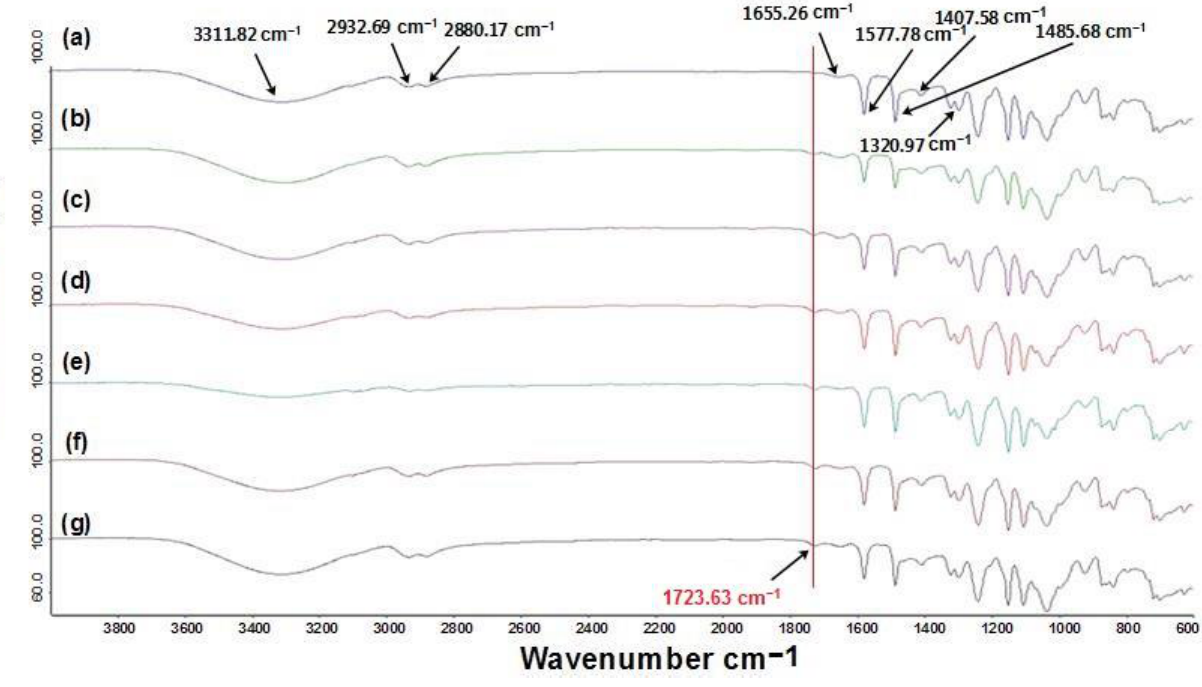
Figure 5. FTIR study of spectra of ( a ) PES, ( b ) PES/PTGM (1 wt.%), ( c ) PES/PTGM (3 wt.%), ( d ) PES/PTGM (5 wt.%), ( e ) PES/PTGM (7 wt.%), ( f ) PES/PTGM (9 wt.%), and ( g ) PES/PTGM (11 wt.%) membranes.